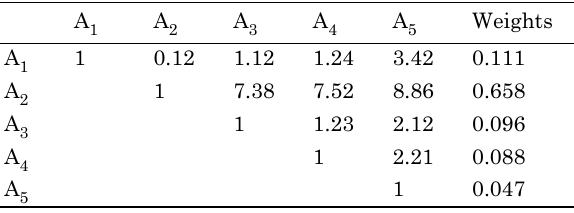
Table 5. Pairwise comparison judgment matrix of each type of exterior walls in the index of resistance potential against seismic loads